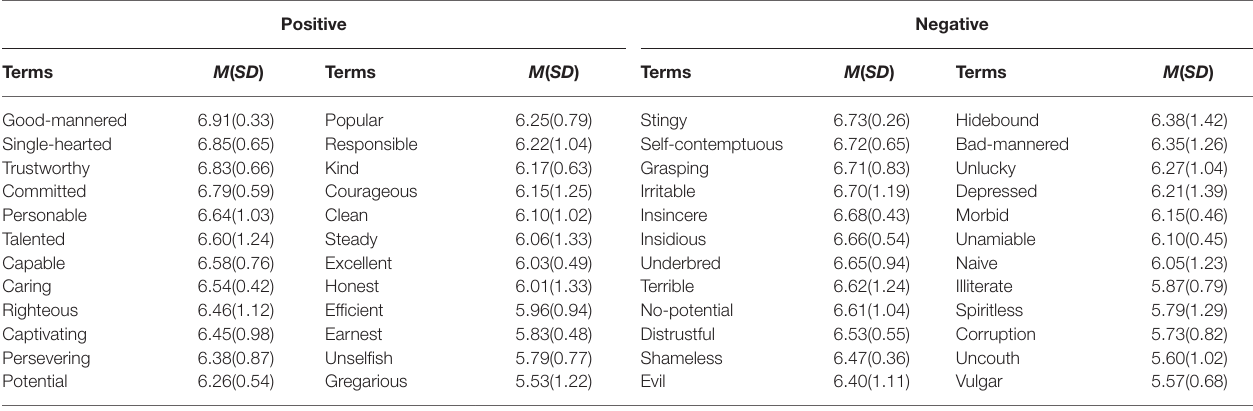
TABLE 1 | All adjective items of “street vendors” and rating scores ( N = 120). Positive